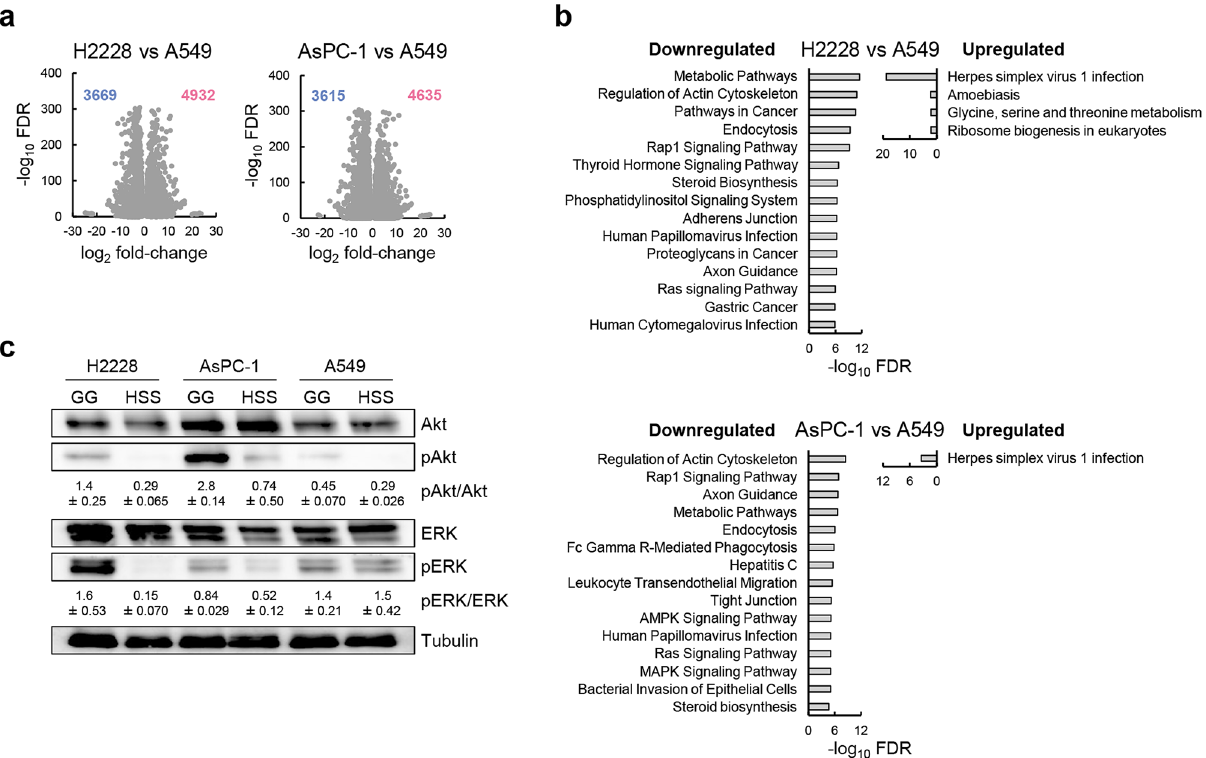
Figure 5. Akt and ERK phosphorylation were downregulated in quiescence-inducible cells under HSS conditions. ( a ) Volcano plot showing DEGs between H2228 or AsPC-1 versus A549 cells under HSS conditions; The number of upregulated and downregulated genes with a cut-off of FDR < 0.1 and fold-change > 2 is shown by red and blue, respectively. ( b ) Enrichment analysis against the Kyoto Encyclopedia of Genes and Genomes (KEGG) database on DEGs in ( a ). The 15 most significant downregulated pathways and all upregulated pathways are shown. ( c ) Immunoblots of total Akt, phosphorylated Akt, total ERK, phosphorylated ERK, and tubulin in H2228, A549, and AsPC-1 cells under GG and HSS conditions. The representative blot and relative signal intensities are shown; n = 3. Original blots are presented in Fig.